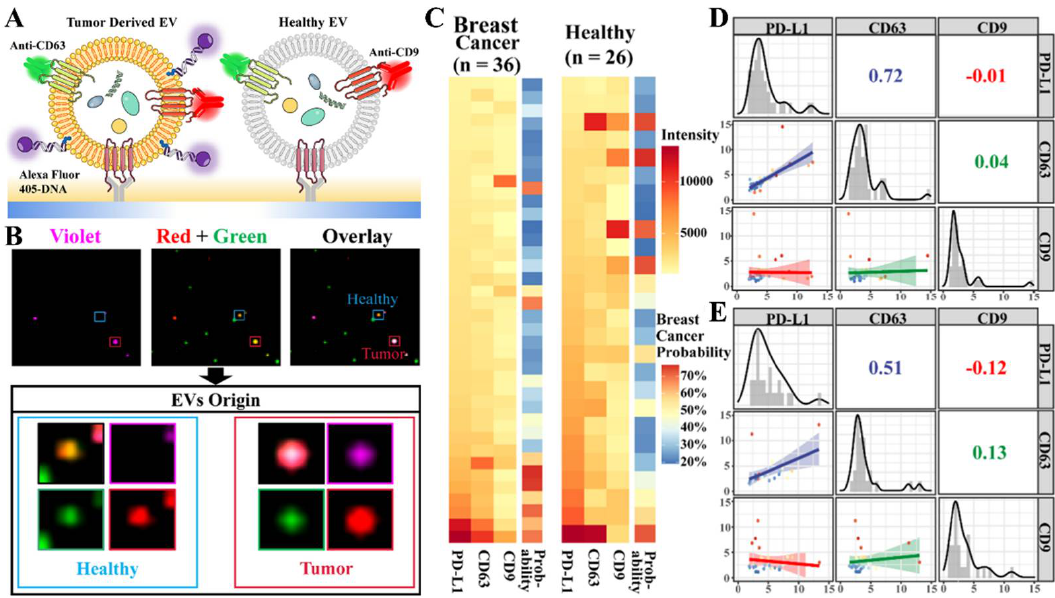
Figure 12. Intelligent probabilistic system for the single EV analysis facilitating the tracing cellular origin. ( A ) Schematic illustration for the analysis of healthy and tumor EVs, using the single EV analysis. ( B ) TIRFM images of the mixed EV samples. ( C ) Phenotyping of the EVs in clinical plasma samples. ( D , E ) Correlation analysis of the PD−L1, CD63 and CD9 expressions for EVs from clinical cancer plasma samples ( D ) and healthy plasma samples ( E ). Reprinted with permission from [106]. Copyright 2021, American Chemical Society.